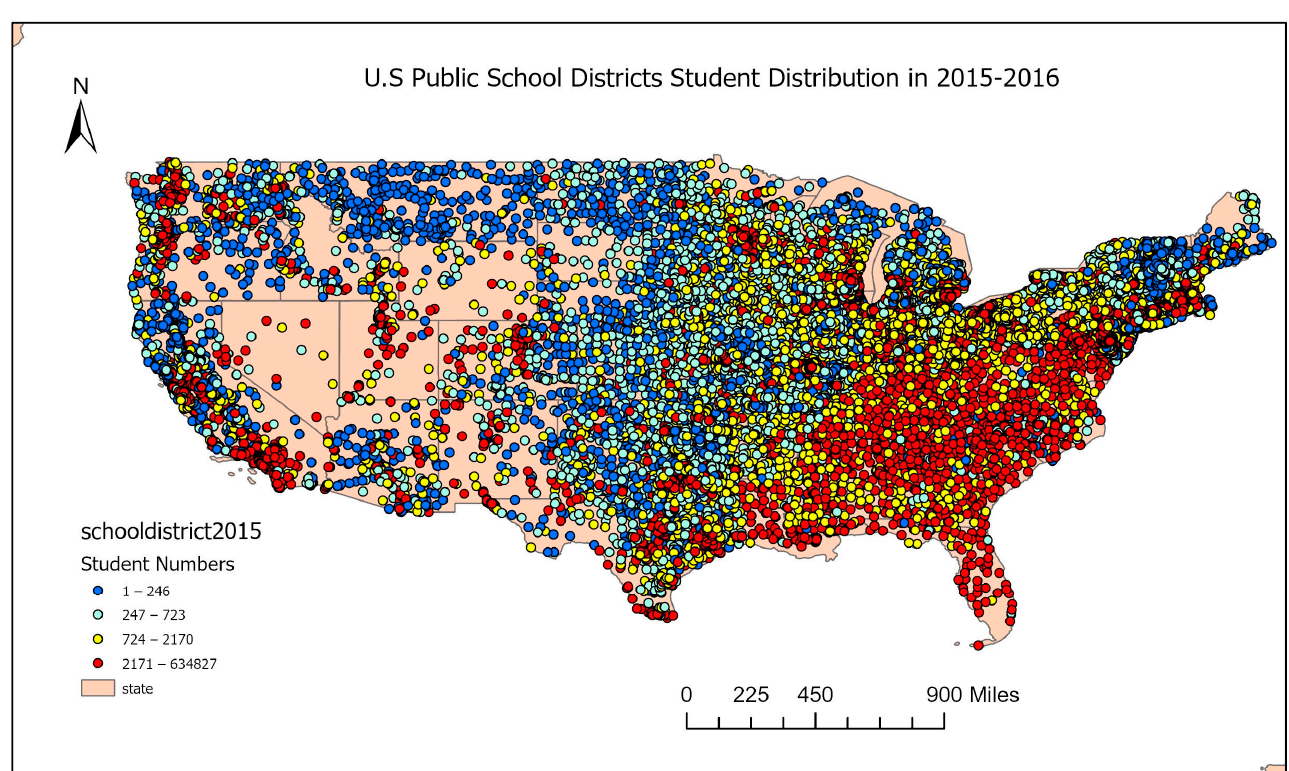
Figure 2. Public school districts student distribution in the U.S.